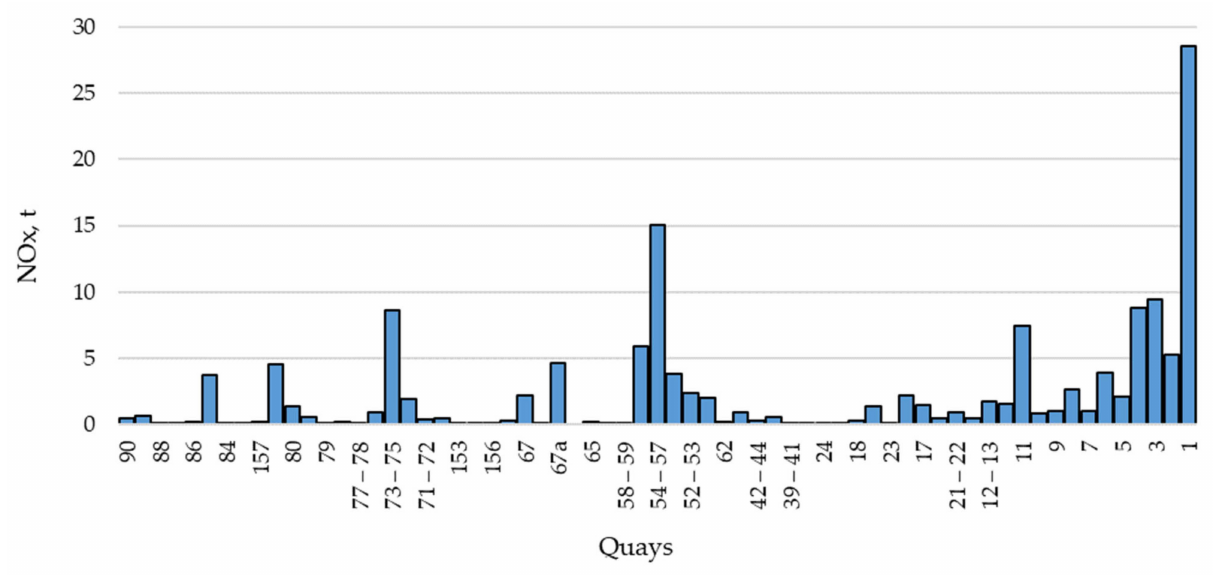
Figure 7. Distribution of emissions in port quays 1–90.